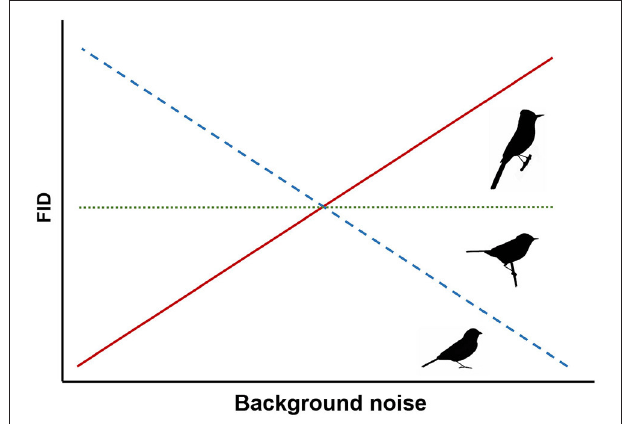
FIGURE 1 | Predicted responses for three foraging guilds of songbirds. We expect ground foragers to have shorter FIDs in noise (dashed line), canopy gleaners to have shorter or unchanged FIDs (dashed or dotted lines), and flycatchers to have unchanged or longer FIDs in noise (dotted or solid